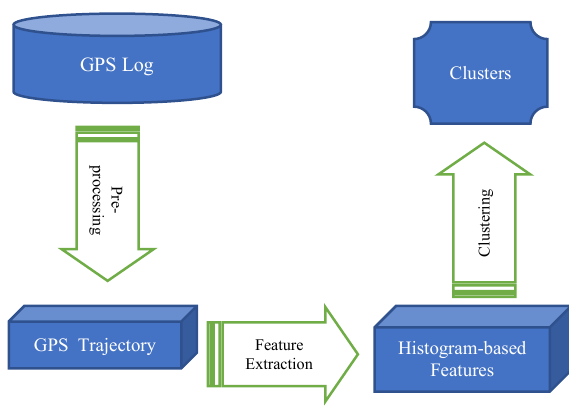
Fig.4. The Framework to detect similar moving